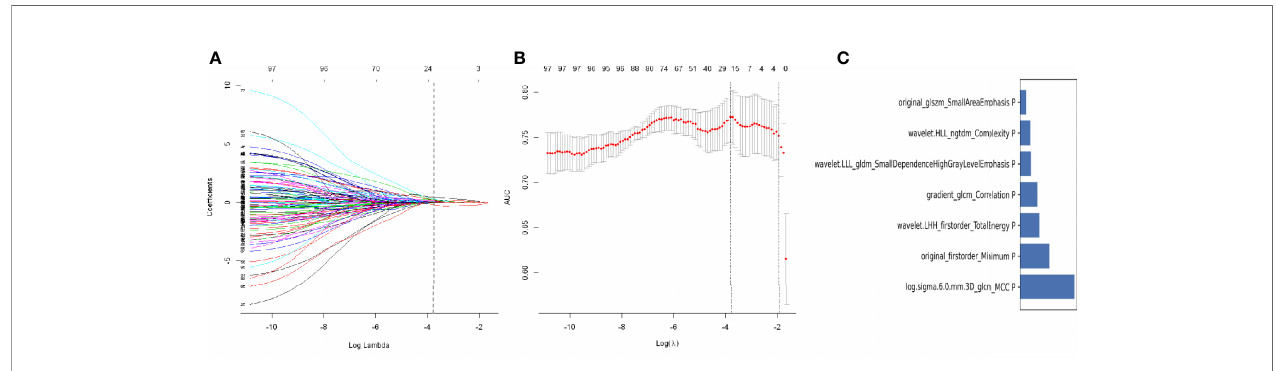
FIGURE 5 | Least absolute shrinkage and selection operator (LASSO) logistic regression of radiomics features (A) and the regularization parameter l (B) . (C) The feature weights of selected radiomics features.